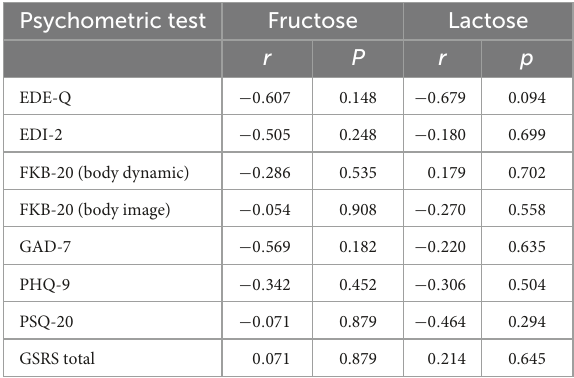
TABLE 3 Correlation between patient-reported outcomes of inpatients and AUC of H 2 values after provocation with fructose or